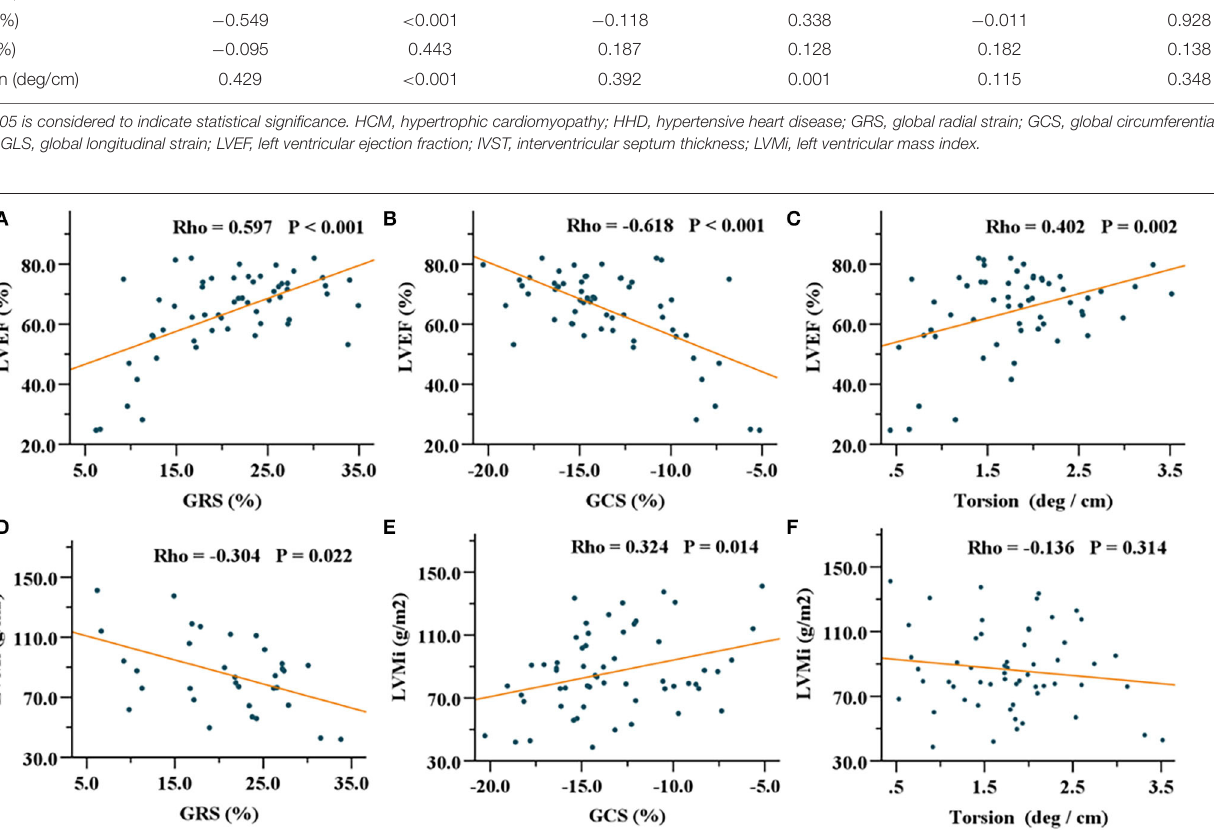
LV torsion may be able to characterize cardiac pump function in the early phase of disease